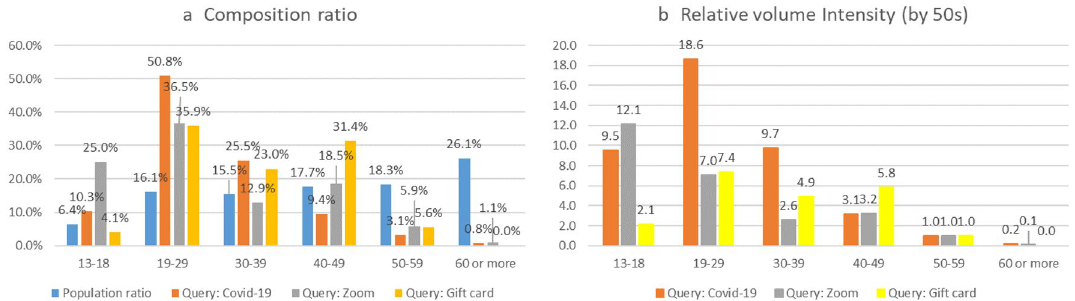
Figure 1. Comparison of search volume distribution by age for key search queries.